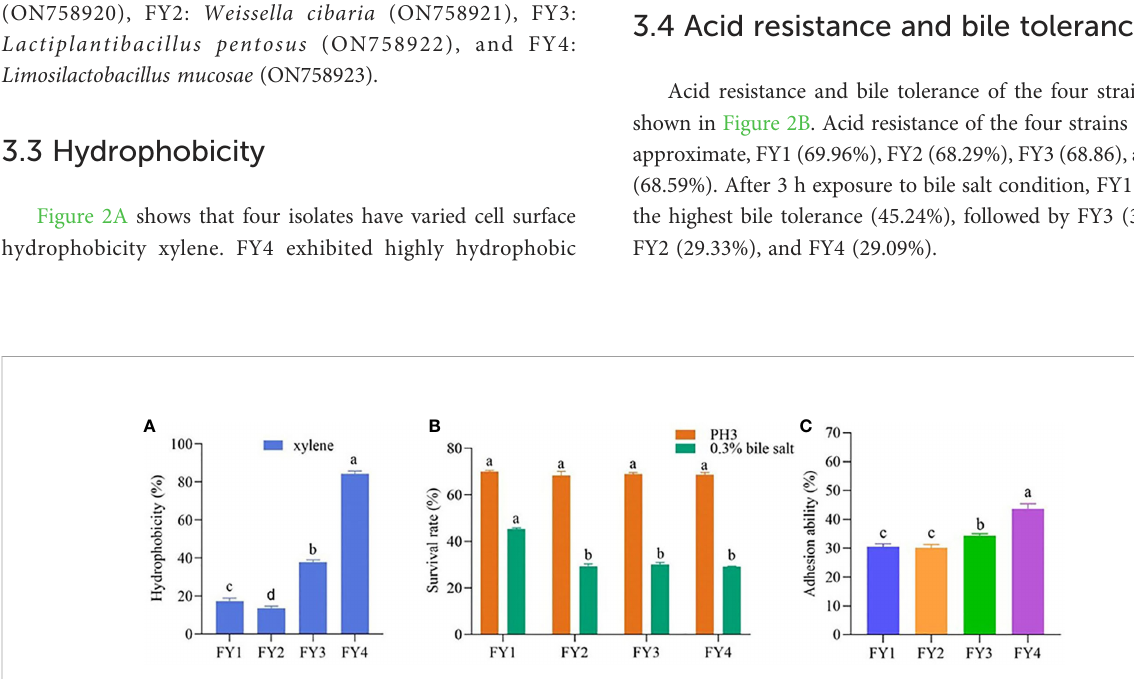
FIGURE 2 The hydrophobicity, acid and bile salt resistance and adhesion ability of LAB isolates. (A) Hydrophobicity percentages of LAB isolates to xylene (B) The acid and bile salt tolerance of LAB isolates. Values expressed as mean ± SD. Different letters represent signi fi cant difference, P< 0.05. (C) Percent adhesion values of LAB to Caco-2. Values expressed as mean ± SD. Different letters represent signi fi cant difference, P < 0.05.